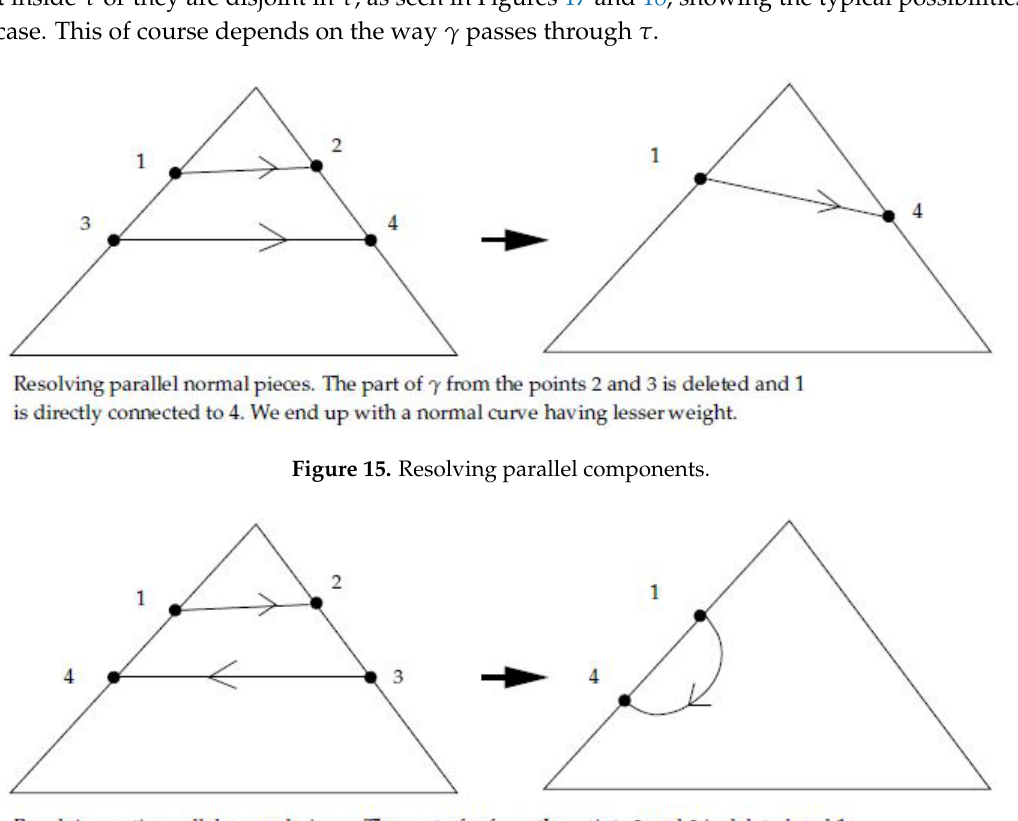
Figure 16. Resolving non parallel